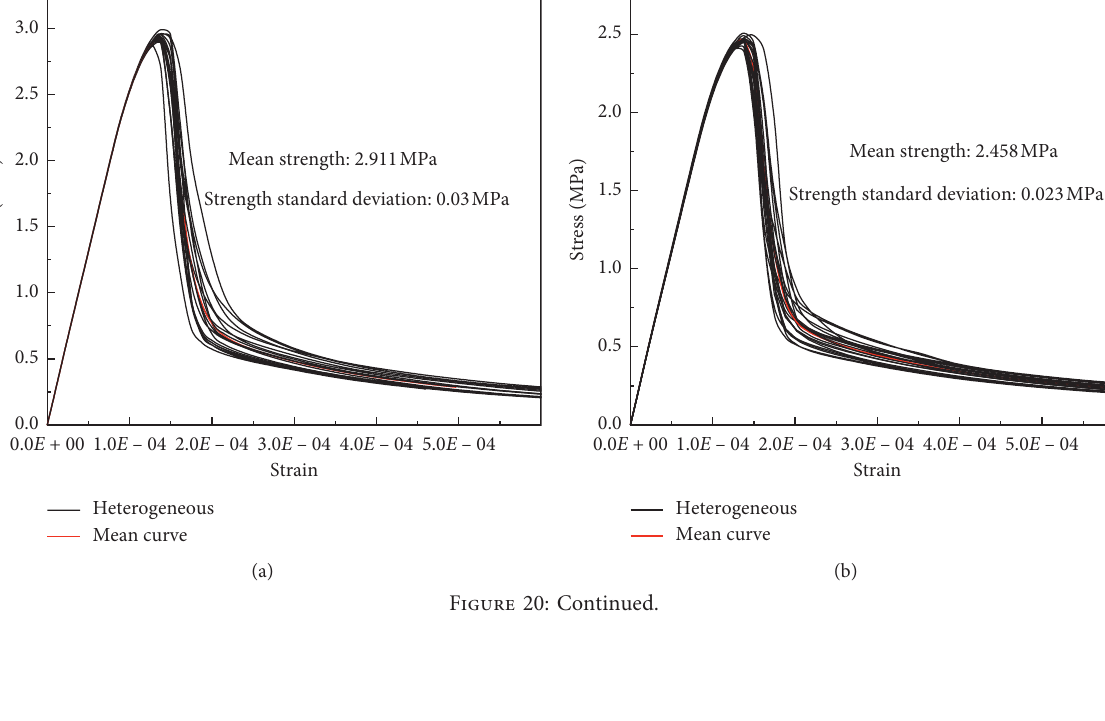
Mean strength: 2.458MPa Strength standard deviation: